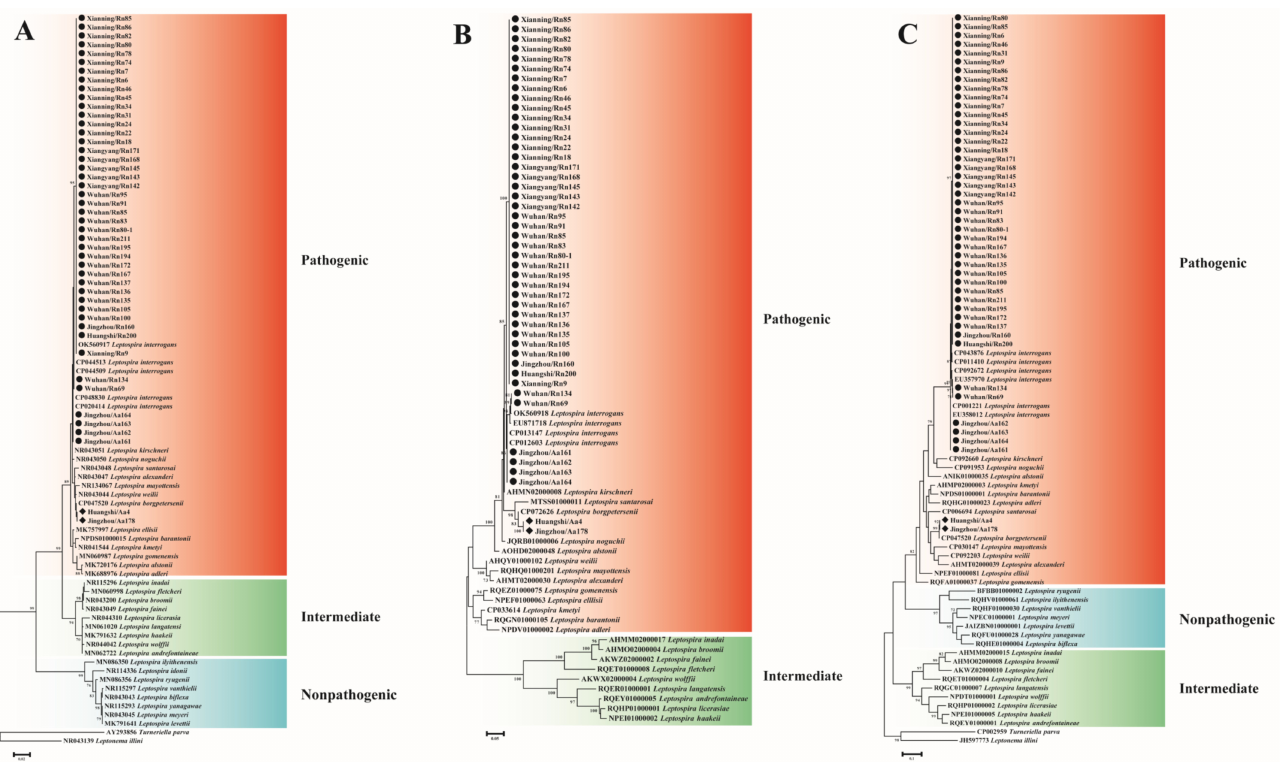
Figure 2. Maximum-likelihood phylogenetic trees based on the nucleotide sequences of rrs ( A ), LipL32 ( B ) and secY ( C ) gene of pathogenic Leptospira . Sequences belonging to this study are displayed by black circles and diamonds. L. interrogans and L. borgpetersenii were identified among these 46 Leptospira strains. Bootstraps values > 70 are indicated at appropriate nodes. (Aa: Apodemus agrarius , Rn: Rattus norvegicus ). Table 2. Species distribution of the 46 pathogenic Leptospira among the different rodents and cities in Hubei. City No. of Individuals No. Per Species (Prevalence, %) L. interrogans L. borgpetersenii Jingzhou